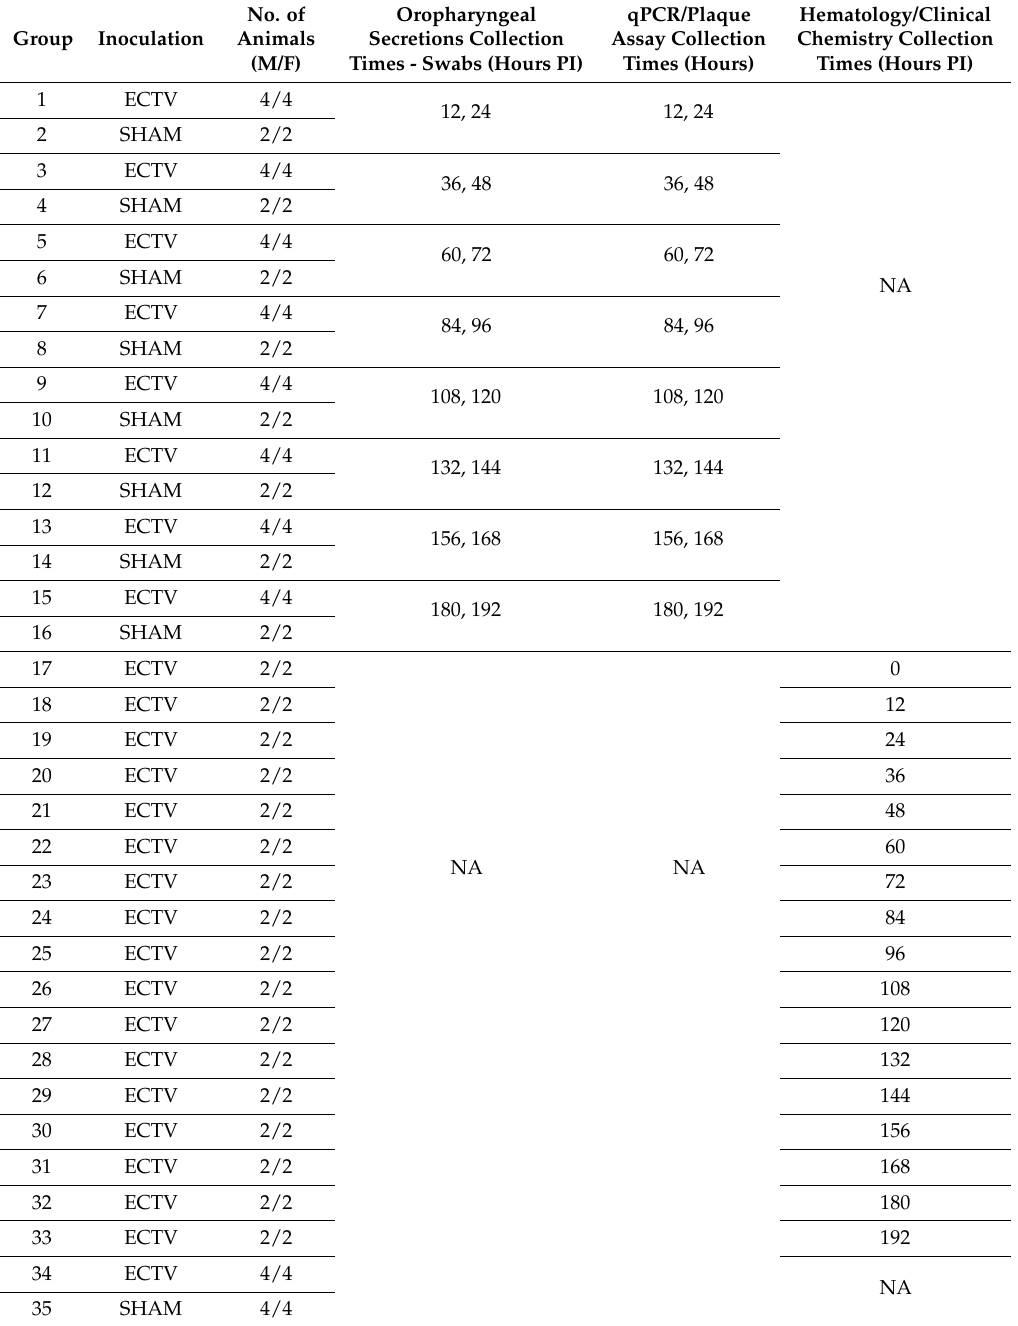
Table 1. Study design of ectromelia virus Moscow strain (ECTV-Mos) characterization in the BALB/c mouse model Group Inoculation